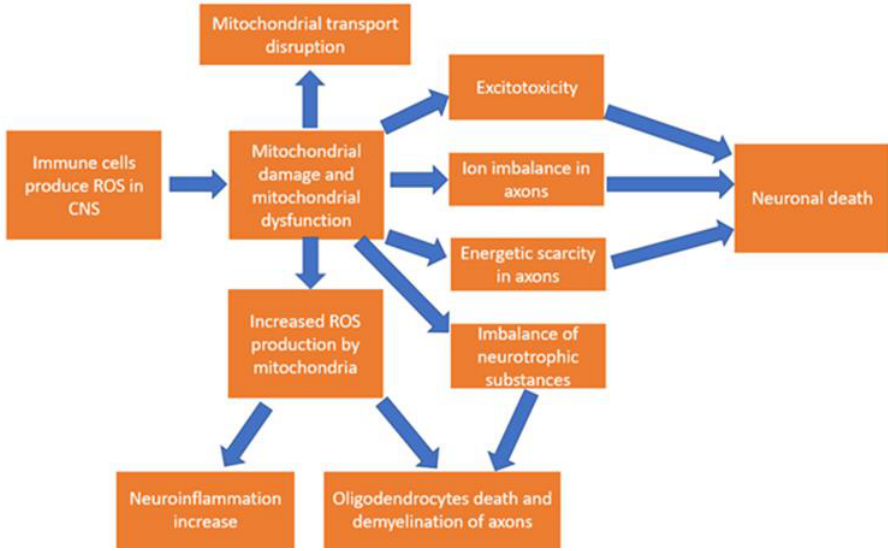
Figure 2. The scheme of MS pathogenesis based on mitochondrial disfunction .